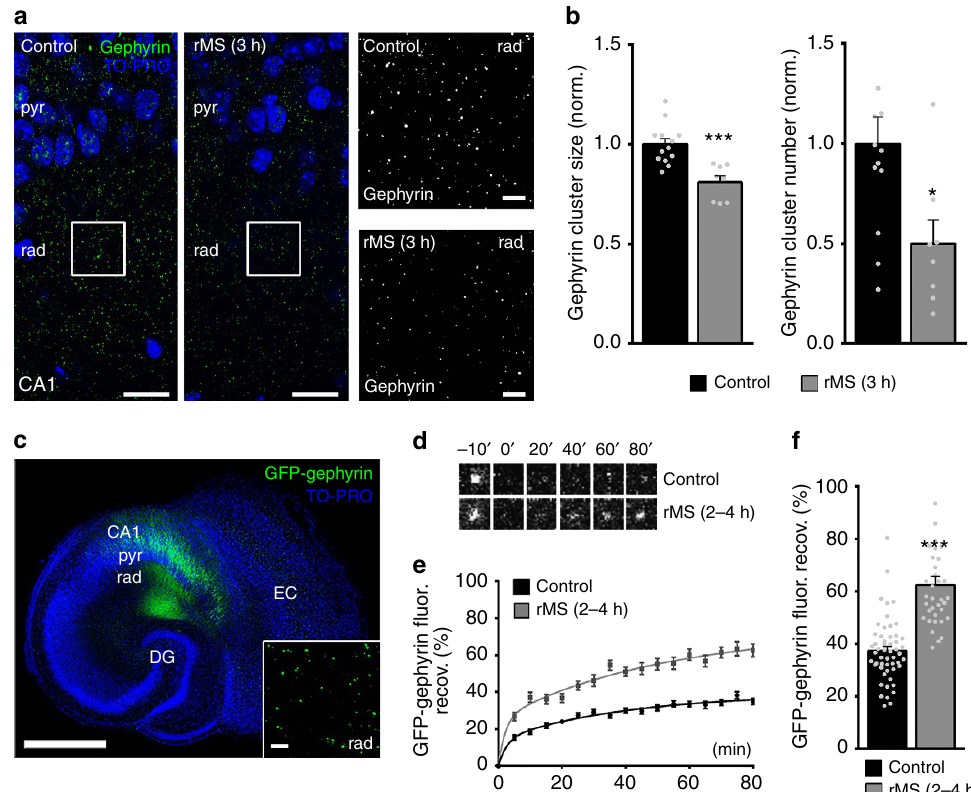
Figure 3 | rMS induces changes in gephyrin cluster properties. ( a ) Stimulated and non-stimulated cultures stained for endogenous gephyrin. Cluster sizes and numbers were assessed in the CA1 stratum radiatum (rad). Blue, TO-PRO nuclear stain; pyr, stratum pyramidale. Scale bars, 30 m m (at higher magnification, 4 m m). ( b ) A reduction in the mean gephyrin cluster size and number is observed after rMS. Values normalized to non-stimulated control cultures (control, n ¼ 13 cultures; rMS, n ¼ 8 cultures; averaged data from three visual fields per culture; Mann–Whitney test; two data points outside the axis limits). ( c ) Overview of a slice culture prepared from a Thy1-GFP/gephyrin mouse. GFP-gephyrin expression (green) is regularly seen in area CA1 in these preparations. FRAP of individual GFP-gephyrin clusters was assessed in the stratum radiatum (rad) of area CA1. Blue, TO-PRO nuclear stain; pyr, stratum pyramidale; DG, dentate gyrus; EC, entorhinal cortex. Scale bar, 500 m m (inset shows GFP-gephyrin clusters at higher magnification; scale bar, 4 m m). ( d ) FRAP images of single GFP-gephyrin clusters in the CA1 stratum radiatum after bleaching at 0min. Series of images taken from a non-stimulated control culture and a culture 2–4h after rMS. ( e , f ) Quantitative evaluation of FRAPexperiments. ( e ) Accelerated GFP-gephyrin FRAP is observed following rMS in vitro . ( f ) Group data for averaged 70–80min FRAP values in non-stimulated and stimulated slice cultures (control, n ¼ 53 clusters from eight cultures; rMS, n ¼ 35 clusters from six cultures; 5–12 clusters bleached per culture; Kruskal–Wallis test followed by Dunn’s post hoc test; one data point in f outside the axis limits; pooled non-stimulated control data). Individual data points are indicated by grey dots. Values represent mean ± s.e.m. (* P o 0.05; *** P o 0.001; ns, not significant